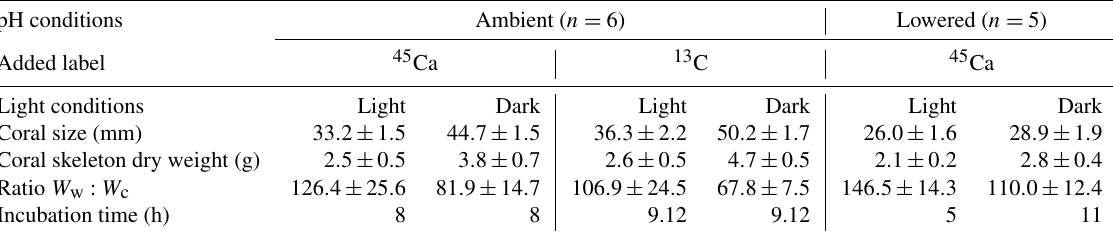
Table 1. Experimental details for the series of incubations of the coral Stylophora pistillata performed under ambient and low pH, and in the light and dark following 45 Ca or 13 C labeling. The ratio W w : W c corresponds to the ratio between seawater weight (g) and skeletal dry weight (g). Values represent mean ± standard deviation (SD); n is the number of true replicates considered for each experiment. All incubations were conducted at 25 ± 0 . 5 ◦